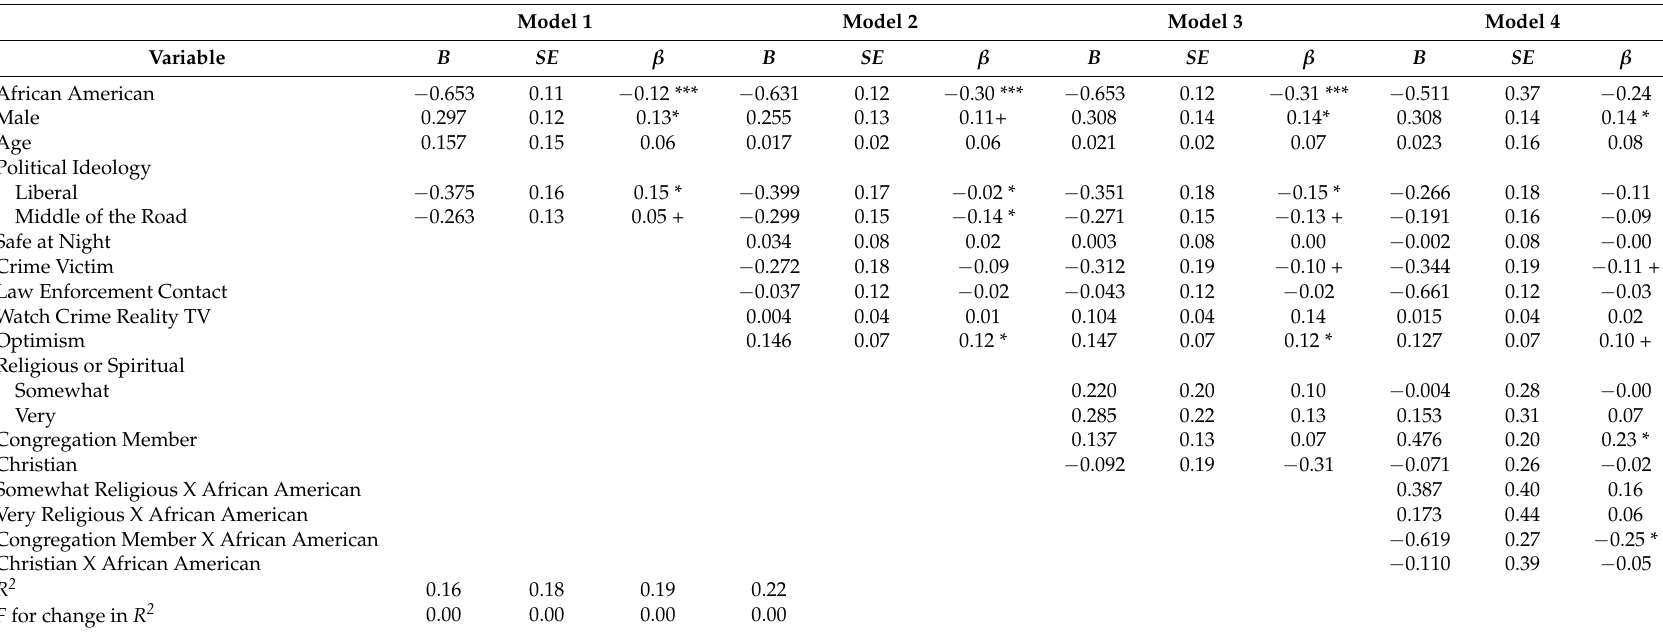
Table 2. Ordinary Least Squares (OLS) Regression Estimates Predicting View of Police (N =